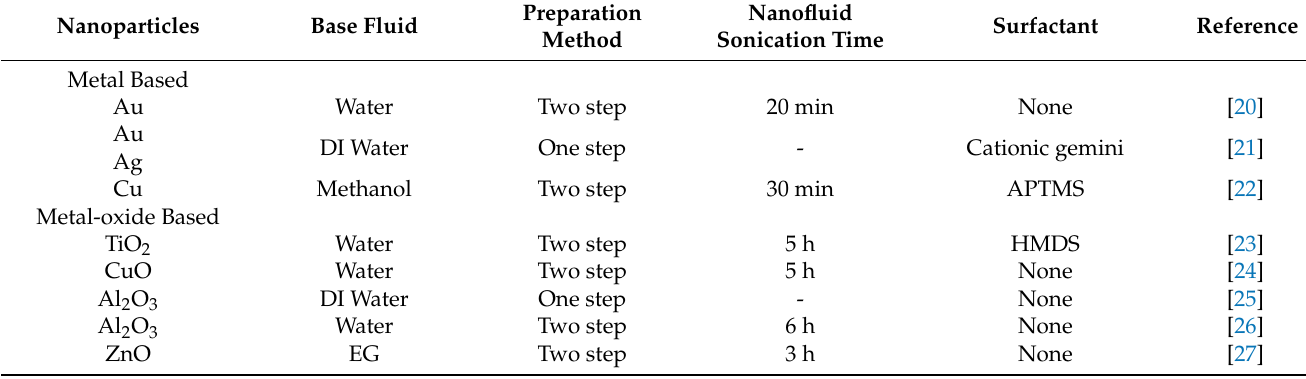
Table 3. Summary of preparation methods and relative surfactant used in past